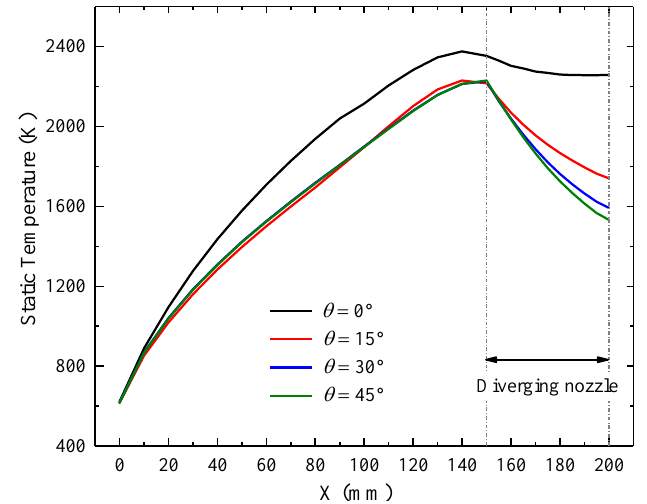
Figure 19. The averaged static temperature in different axial cross-sections of the RDC at t = 3980 μs.